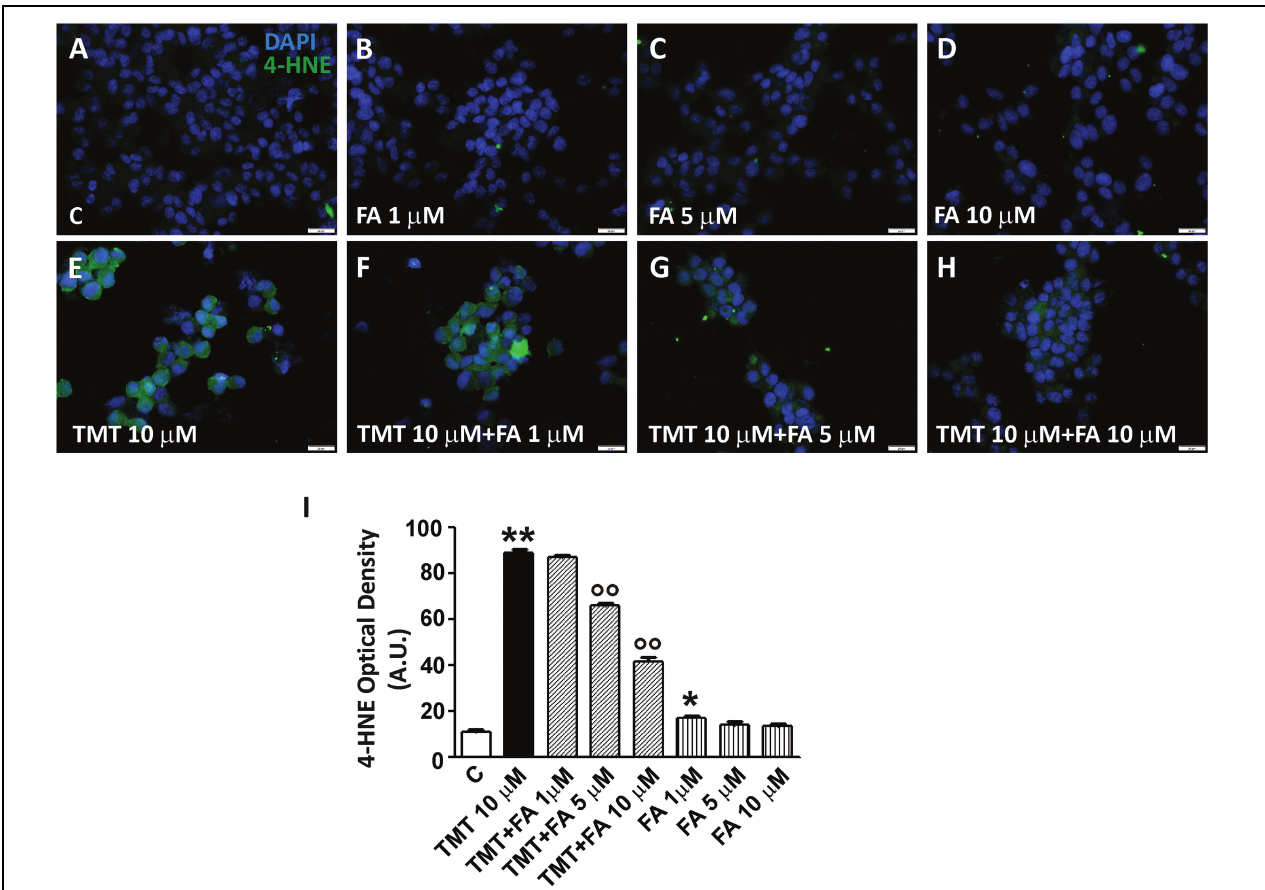
FIGURE 5 | Ferulic acid counteracts the increase of lipid peroxidation induced by TMT in a dose-dependent manner. (A–H) Representative immunofluorescence images of SH-SY5Y cells treated with TMT (10 μ M) and/or FA (1–10 μ M) and double stained with DAPI (blue) and anti-4-HNE antibody (green). 4-HNE labeling was faint in control cells (A) , but mildly increased in cells treated with different doses of FA (B–D) . After TMT treatment, there was a marked increase of 4-HNE fluorescence (E) that decreased in a dose-dependent manner when FA was added (F–H) . (I) Histograms (mean ± SEM) showing optical density quantification in treated cells for 4-HNE labeling. Data are representative of three independent experiments; each count was performed on five fields randomly selected for each experimental condition. Scale bar (A–H) 20 μ m. ∗ P < 0.05, ∗∗ P < 0.01 vs. controls (C) , ◦◦ P < 0.01 vs.